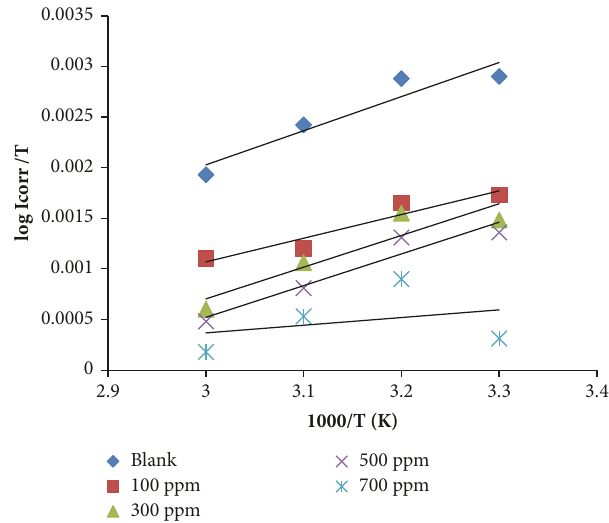
Figure 10: Transition state plot for brass corrosion with and without BFC in 1 M HCl at 60 ∘ C